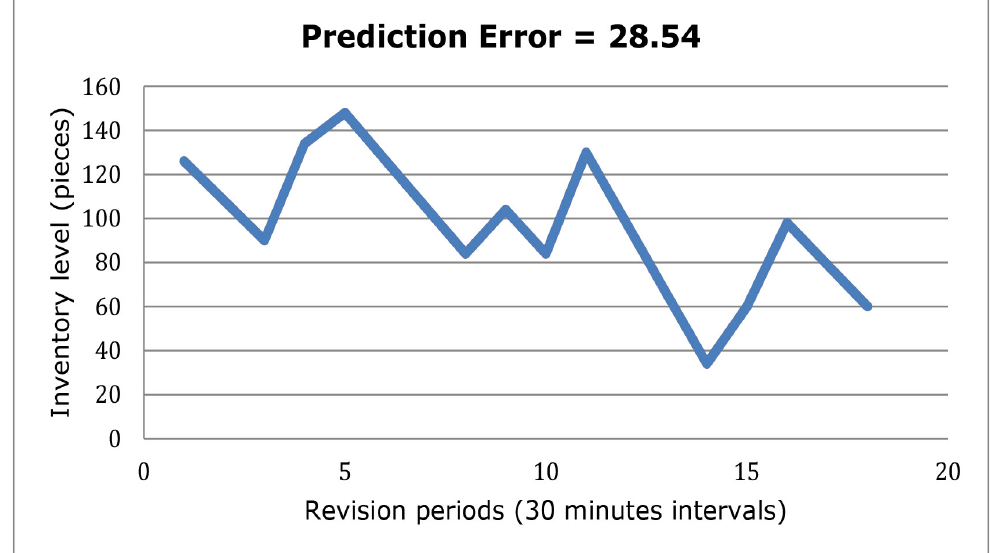
Figure 2. Inventory level based on report of the critical required components